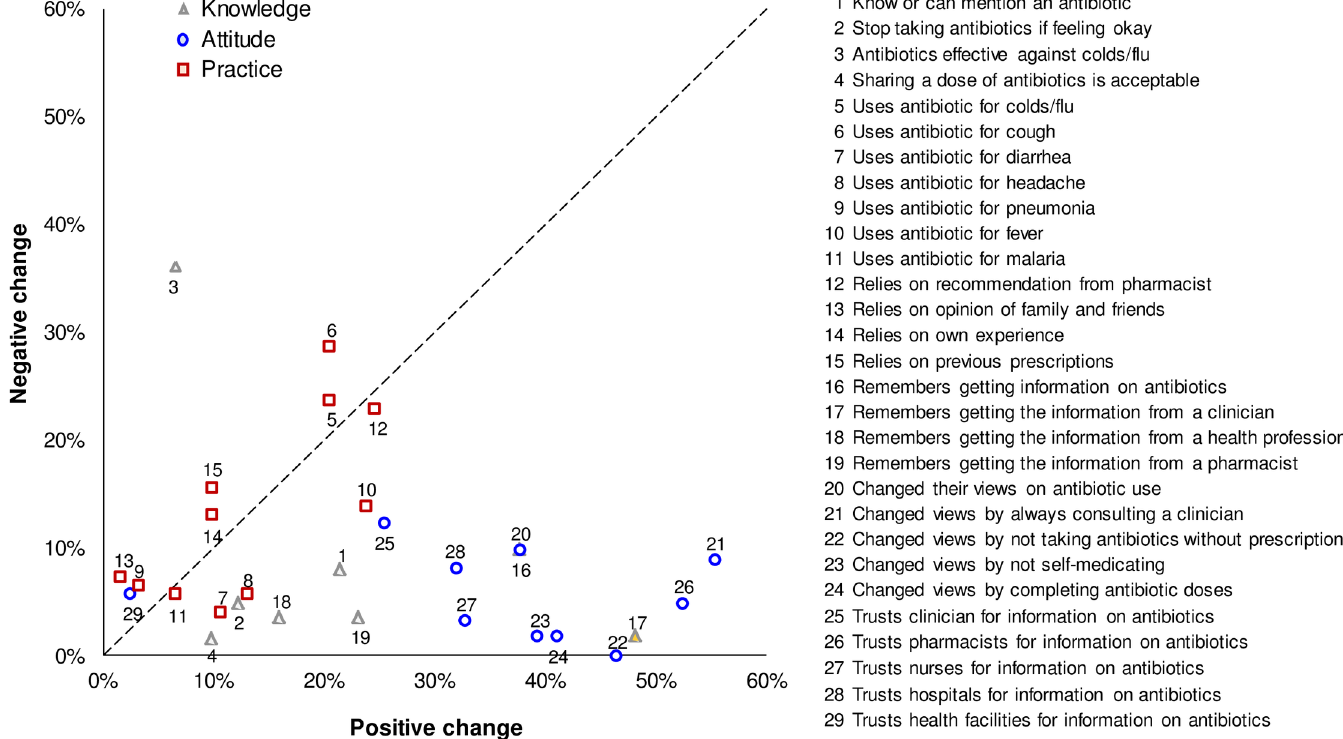
Fig 2. Plot showing the direction of change (entry versus the exit survey) in household responses (n = 122). Twenty-nine knowledge,attitude and practices variableswere analyzed.Dashedline depicts no change betweenentry and exit surveys, variablesabovethe dashedline depict negativechange while those belowit depict positive change.Variablesnear the line depict little changewhilethose far from the line depict greater change.Each point represents the proportionof householdsthat changedtheir responseseither negativelyof positivelyduringthe exit survey comparedto the entry survey. Details regardingthe determination of the directionof change(positiveor negative)are providedin S1